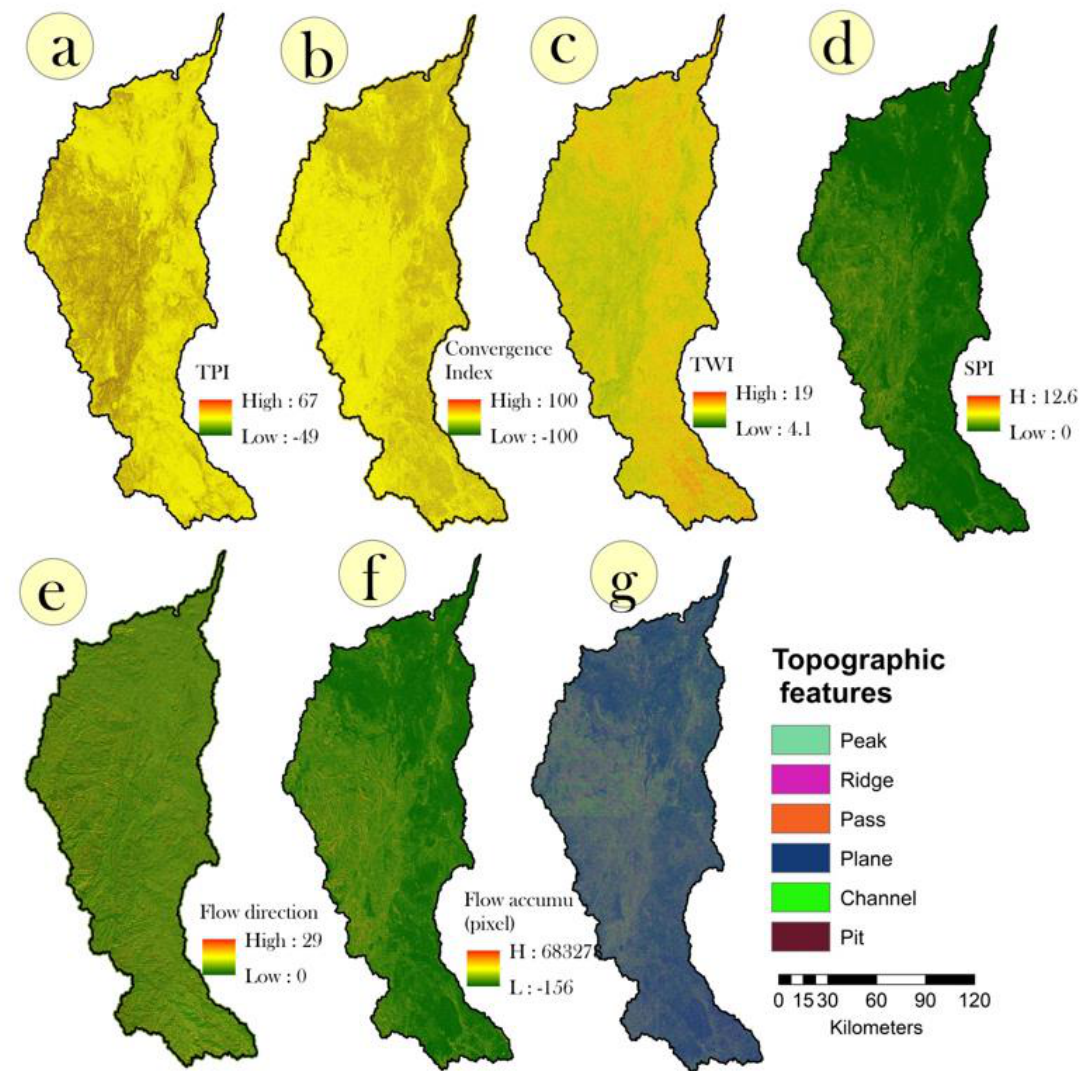
Figure 3. DEM derived topographic and hydrologic parameters, such as ( a ) TPI, ( b ) convergence index, ( c ) TWI, ( d ) SPI, ( e ) flow direction, ( f ) flow accumulation, and ( g ) topographic